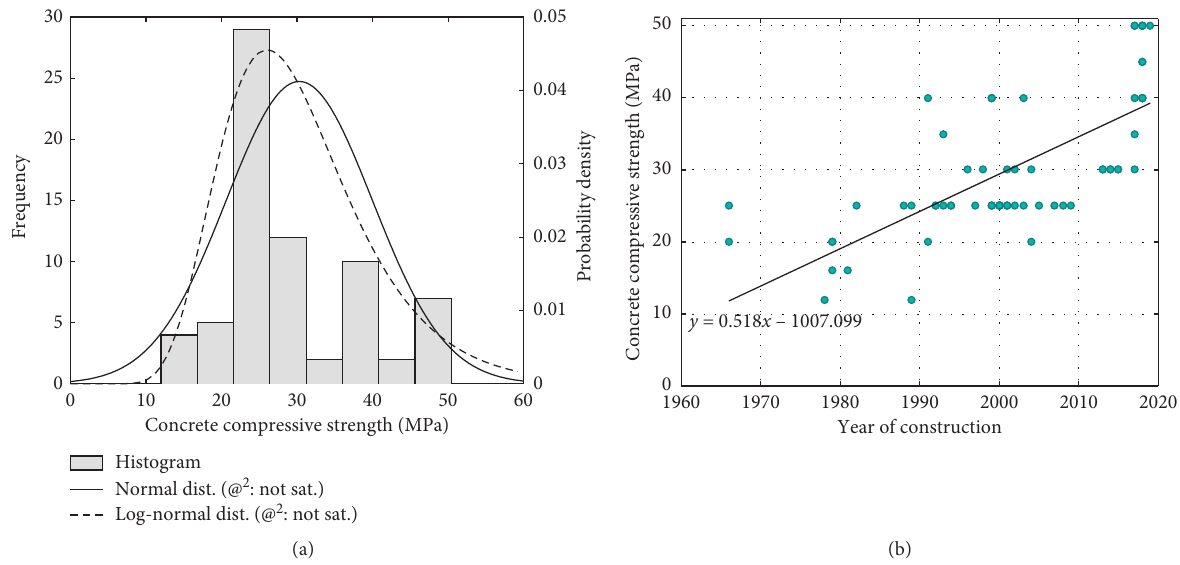
Figure 16: Concrete compressive strength: (a) histogram and probability distributions associated with the concrete compressive strength and (b) evolution with period of construction.